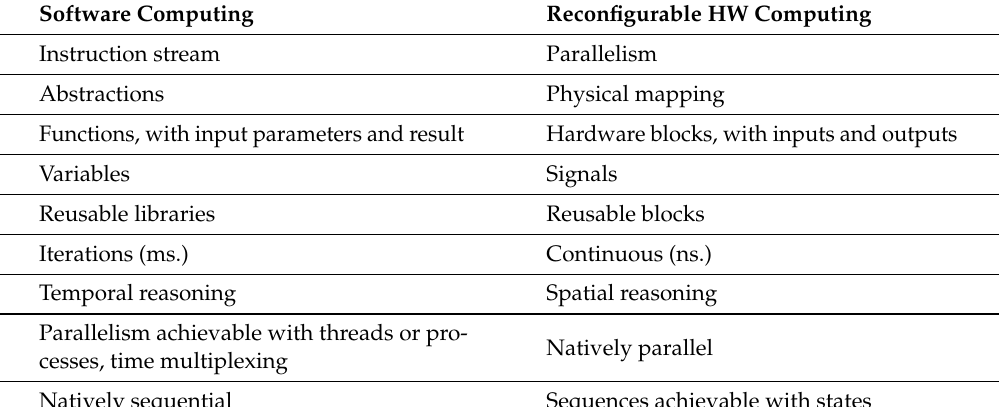
Table 5. Qualitative comparison between software computing and reconfigurable hardware